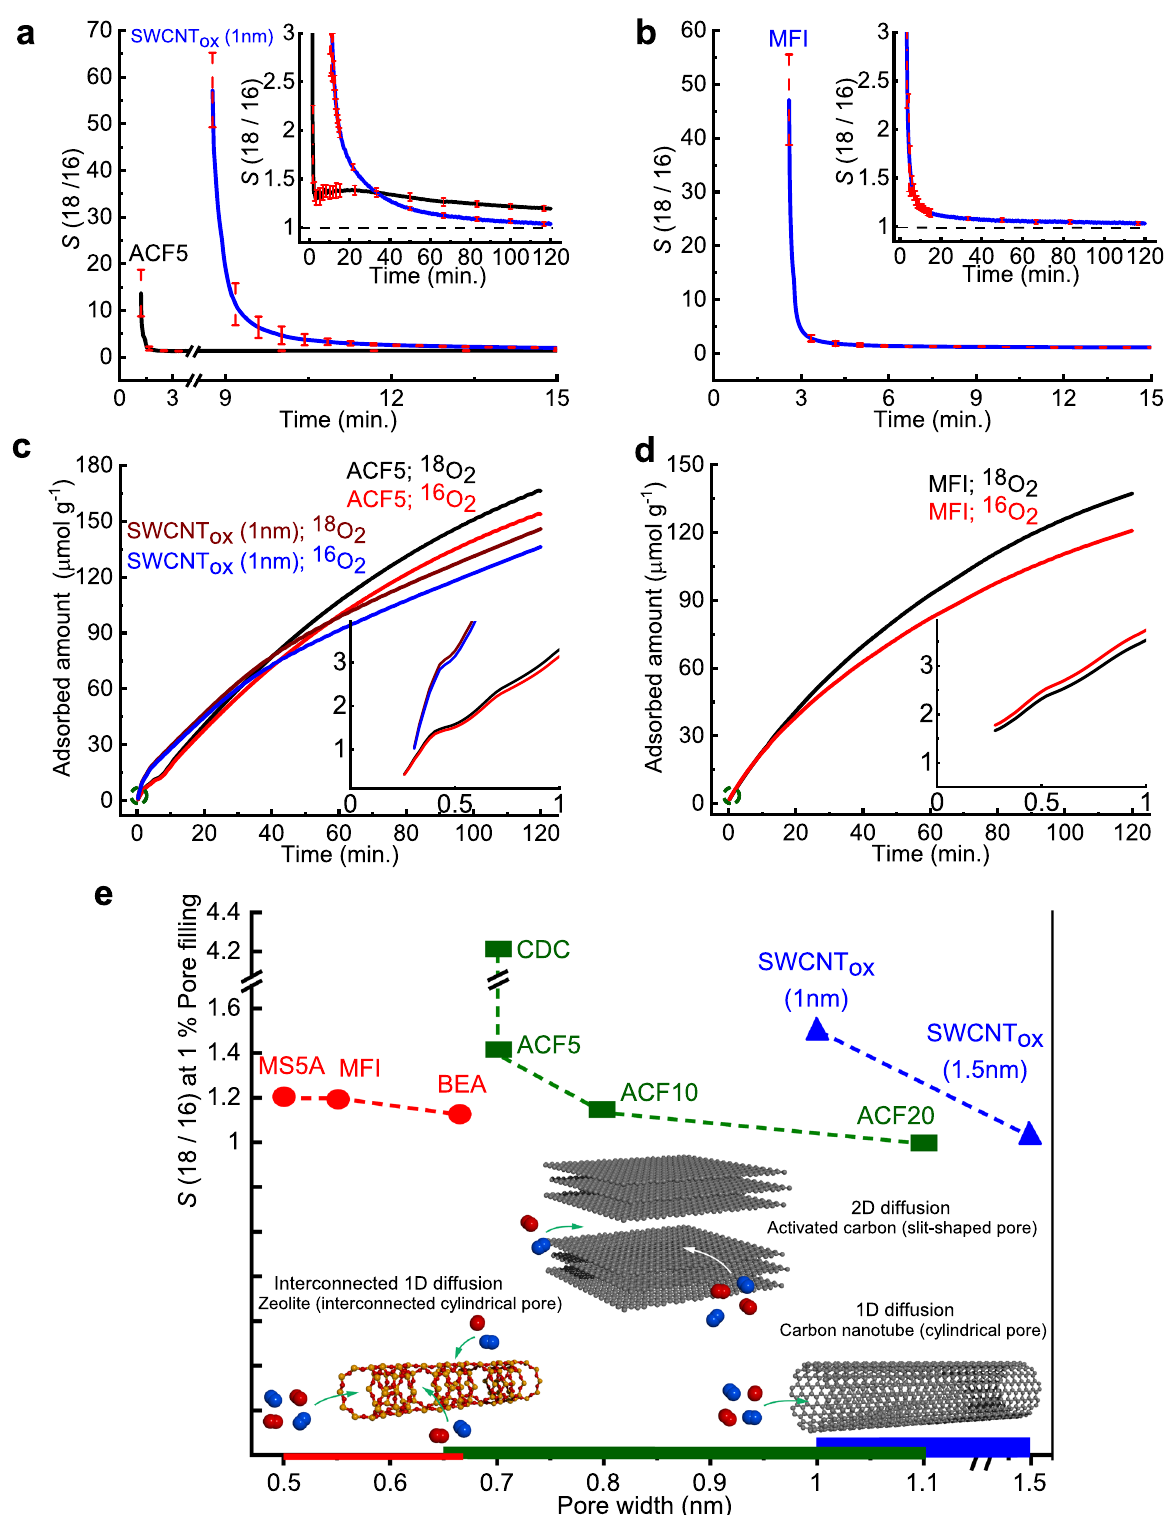
O 2 – SWCNT interactions, resulting in mass-dependent NQEs in the rotational, vibrational, and translational degrees of freedom. However, these pores are too small to induce the observable O 2 adsorption experimentally. In contrast, adsorption in the (7,7) and (10,10) SWCNTs at zero loading shows very low